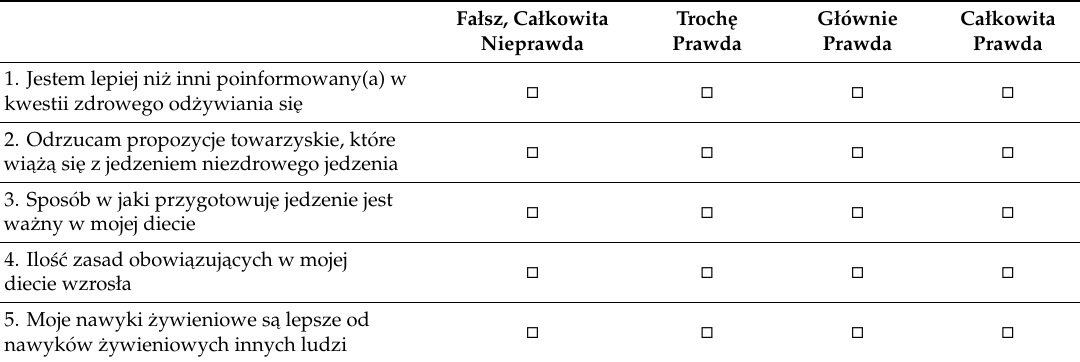
Table A1. The Polish version of the